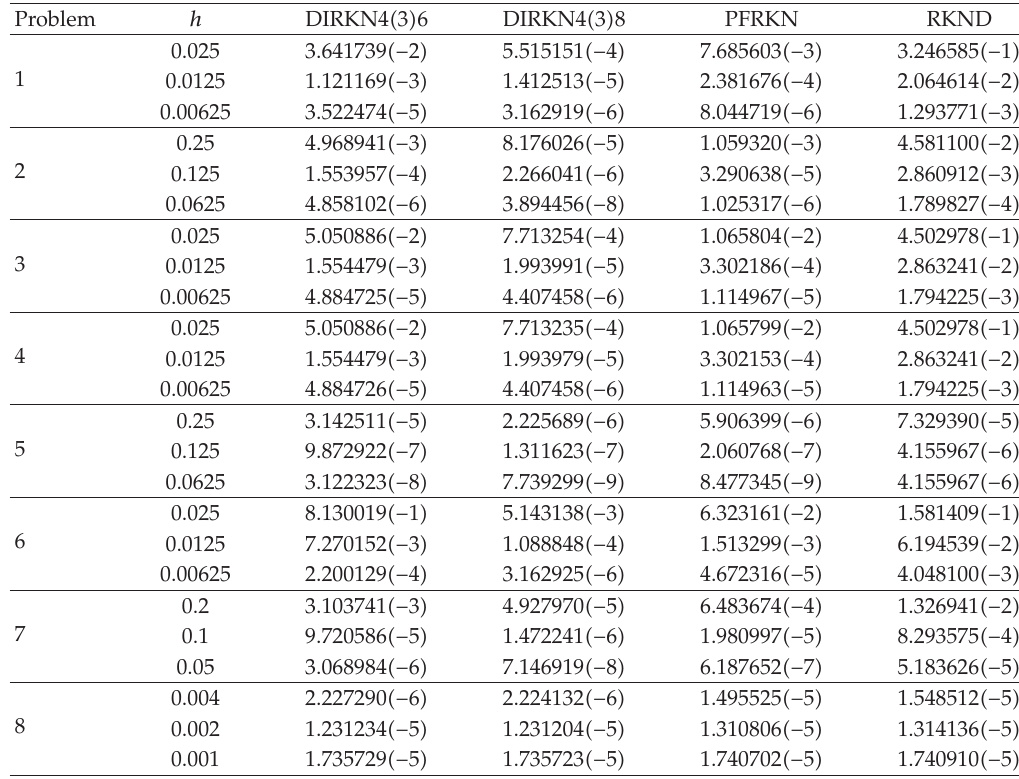
Table 4: Numerical results for Problem 1 to Problem 8 with t end (cid:6) 10 4